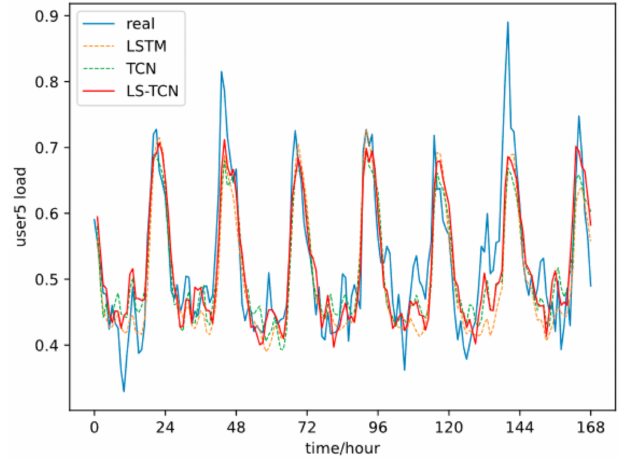
Figure 7. Comparison of the actual load of a single user with the predicted result. Table 5. Generalization MAPE error of each